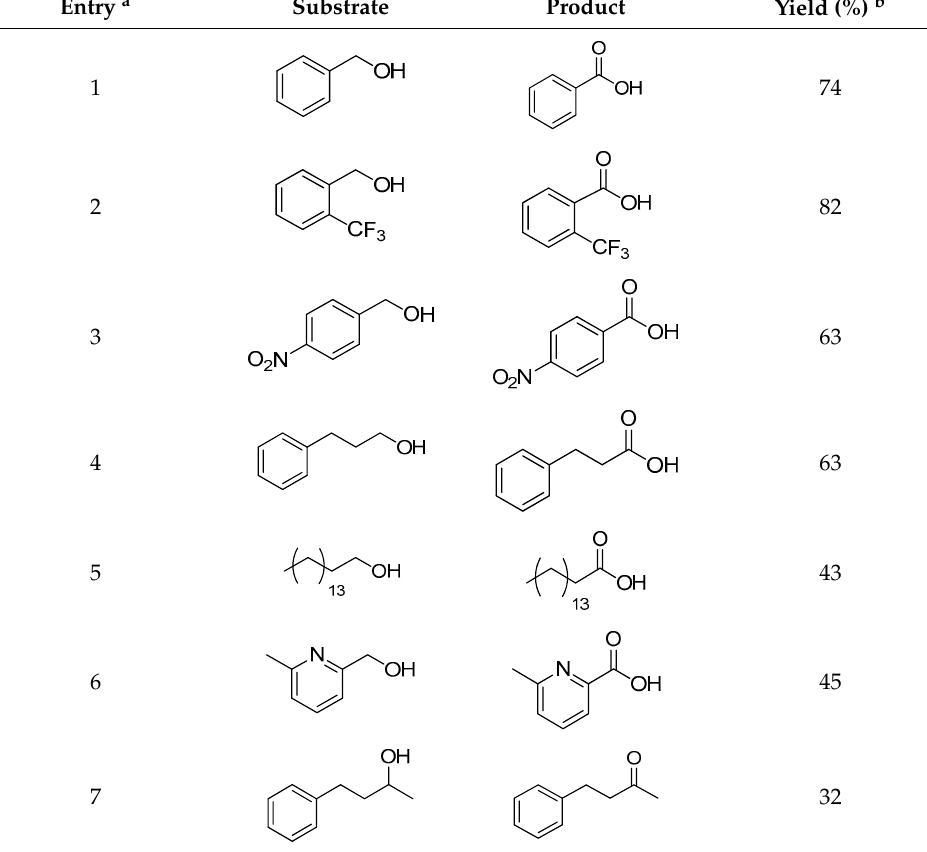
catalyst/product separation by a reusable steric polymer column and purification if necessary.